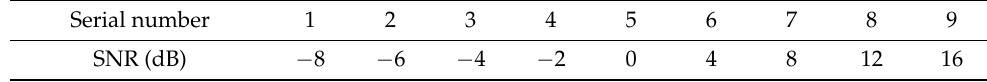
Table 1. SNR selection in listening